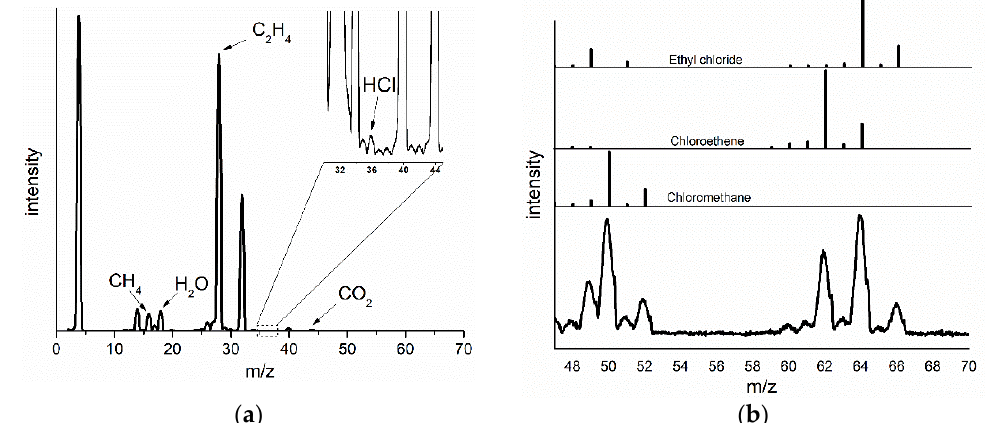
Figure 2. ( a ) Mass spectrum of the product of ethane oxidative dehydrogenation (ODH) over S-ACl, full-spectrum, and ( b ) details of low-intensity signals at m / z 45–70. At the bottom is displayed the experimental mass spectrum, above that are the model spectra of the three most probable chlorinated compounds formed during the reaction.